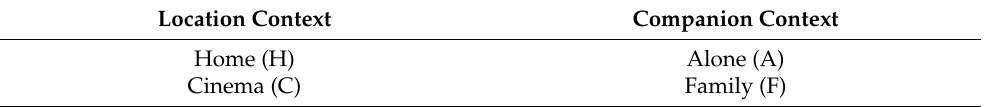
Table 1. Example of contextual